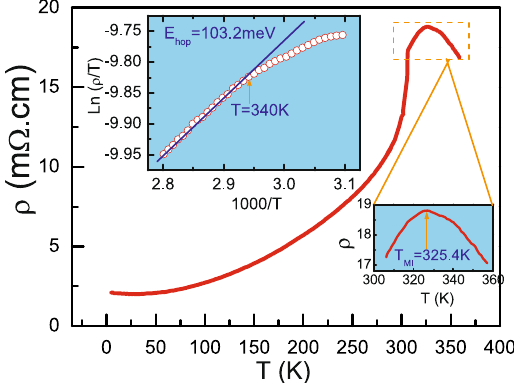
Figure 4. The resistivity as a function of temperature for La 0.6 Er 0.1 Sr 0.3 MnO 3 . The left inset shows Ln( ρ /T) versus 1000/T and the solid line is the linear fit according to Eq. (3) and the right one shows the magnified ρ (T) in the EPS